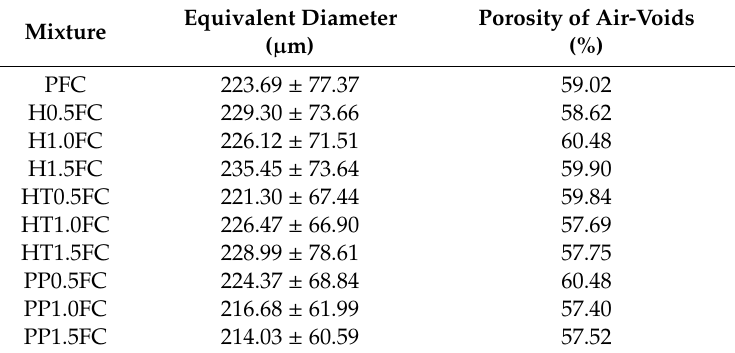
Table 6. Average equivalent air-void diameter of the mixtures.